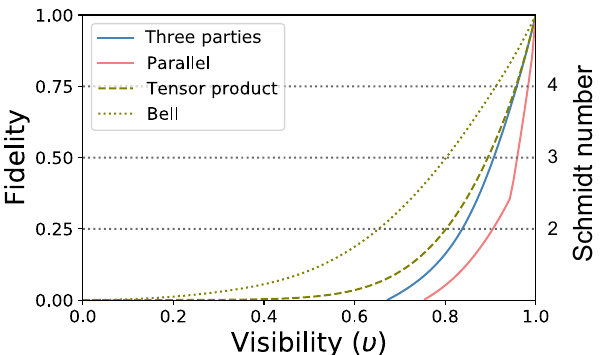
FIG. 5. Certifiable fidelities in the three-party and parallel self-testing scenarios. The minimum fidelity certifiable with our protocol, in the simple CHSH scenario (dotted curve) [31], in the three-party scenario (blue curve) and in the scenario of two parties sharing two singlets; that is, the parallel self-testing sce- nario (red curve) [42]. The dashed curve represents the fidelity bound that would be obtained through the assumption that the state generated by the network is made of a tensor product of two quantum states, each shared between two parties (i.e., in a semi- device-independent setting). In the Bell case, the target state is a two-qubit maximally entangled state, | ψ (cid:3) , while in the other cases, the target is a product of two two-qubit maximally entan- ⊗ | ψ (cid:3) | ψ (cid:3) ⊗ gled states | ψ (cid:3) A A 2 C (three-party scenario) and A 1 B 1 1 B | ψ (cid:3) A 2 B 2 (parallel self-testing scenario). The fidelities are plotted in terms of the visibilities of the generated states. In partic- ular, we consider that in the CHSH case, the generated state would have the following form: ρ AB = υ | ψ (cid:3)(cid:8) ψ | + ( 1 − υ) I / 4. ⊗ ρ ρ = ρ = In the three-party case, ρ ABC = ρ A A 2 C , with A 1 B A 2 C 1 B υ | ψ (cid:3)(cid:8) ψ | + ( 1 − υ) I / 4. In the parallel self-testing case, analo- ⊗ ρ ρ = ρ = υ | ψ (cid:3)(cid:8) ψ | + gously, ρ AB = ρ A A 2 B 2 , with A 1 B 1 A 2 B 2 1 B 1 ( 1 − υ) I / 4. The horizontal dotted gray lines correspond to k / 4, with k ∈ ( 1, 2, 3 ) , and indicate the thresholds over which the fidelity guarantees a Schmidt number (and therefore an entangle- ment dimension) higher than k + 1 (i.e., 2, 3, and 4,